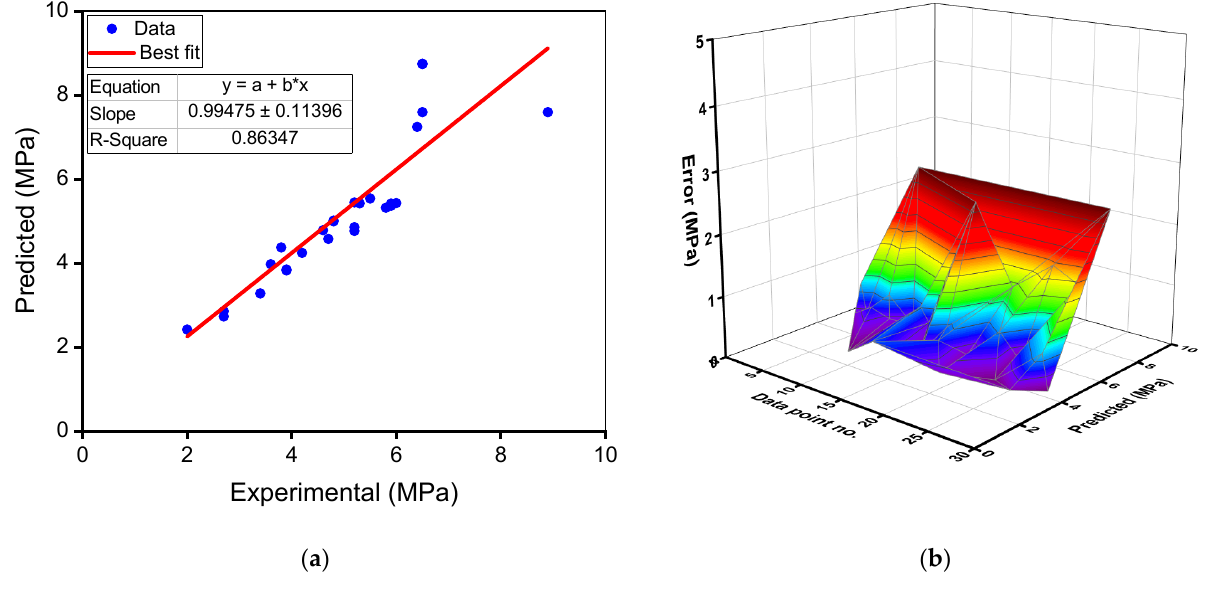
Figure 9. Random forest model for flexural strength: ( a ) relationship between experimental and predicted results; ( b ) spreading of predicted and error values.